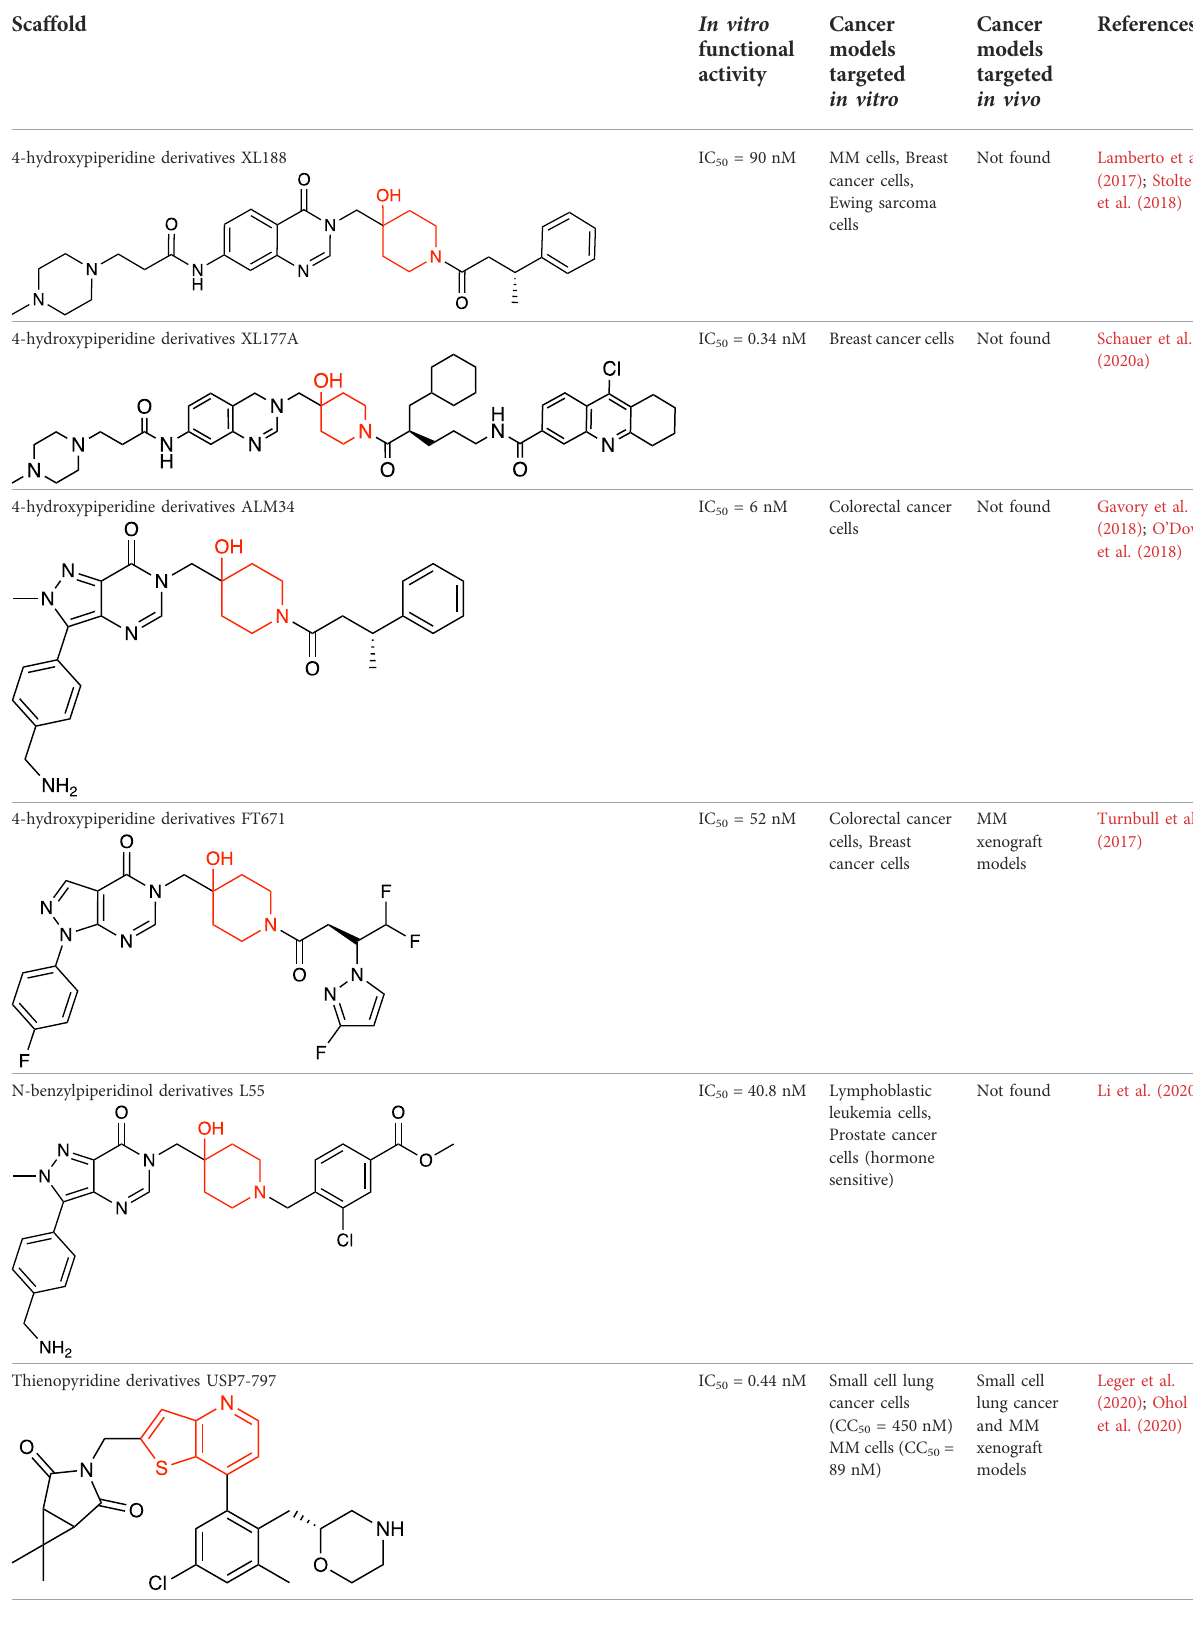
TABLE 1 ( Continued ) Representative structures of the most potent USP7 inhibitors